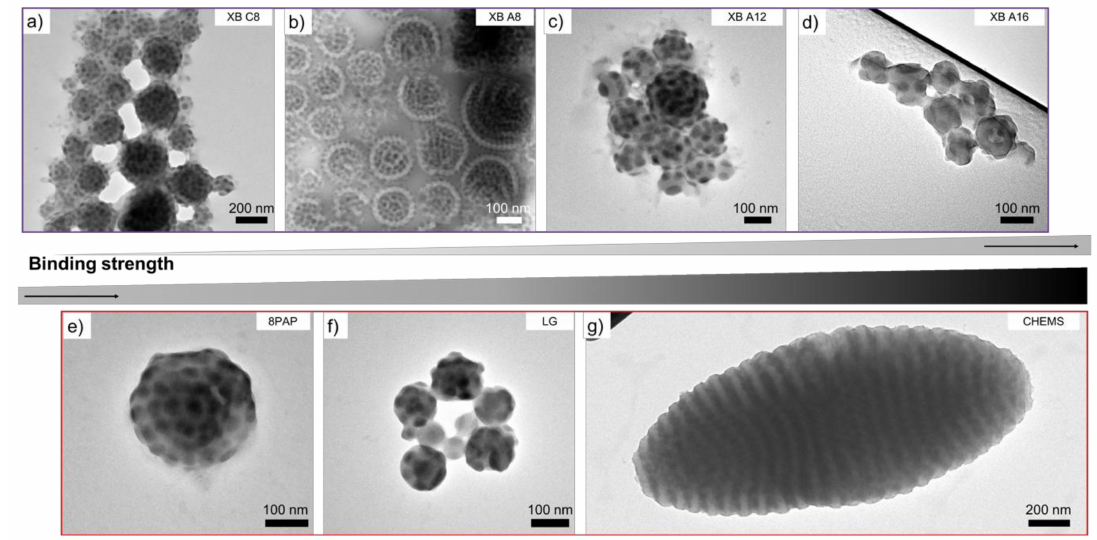
Figure 3. Microparticles of SVT1 loaded with a molar fraction of bonders x = 1.00. TEM images of spherical microparticles with ls morphology obtained for ( a ) XB C8, ( b ) XB A8, ( c ) XB A12, ( d ) XB A16, ( e ) 8PAP, and ( f ) lauryl gallate (LG). Elliptic particles obtained for ( g ) cholesteryl hemisuccinate (CHEMS). (Color code in TEM image: PS grey, P4VP dark grey due to iodine staining).